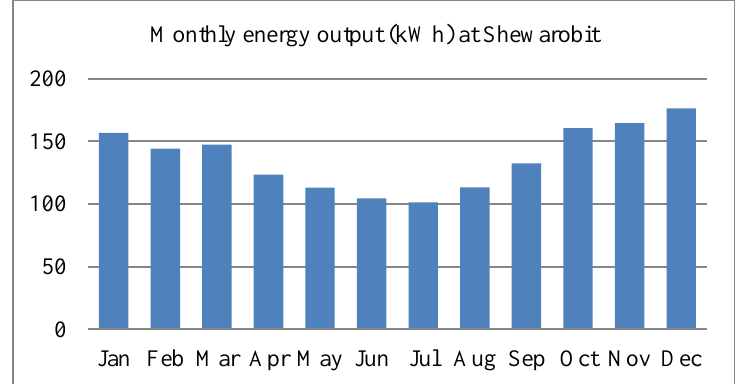
Figure 6. Energy assessment of solar system at Shewa Robit.